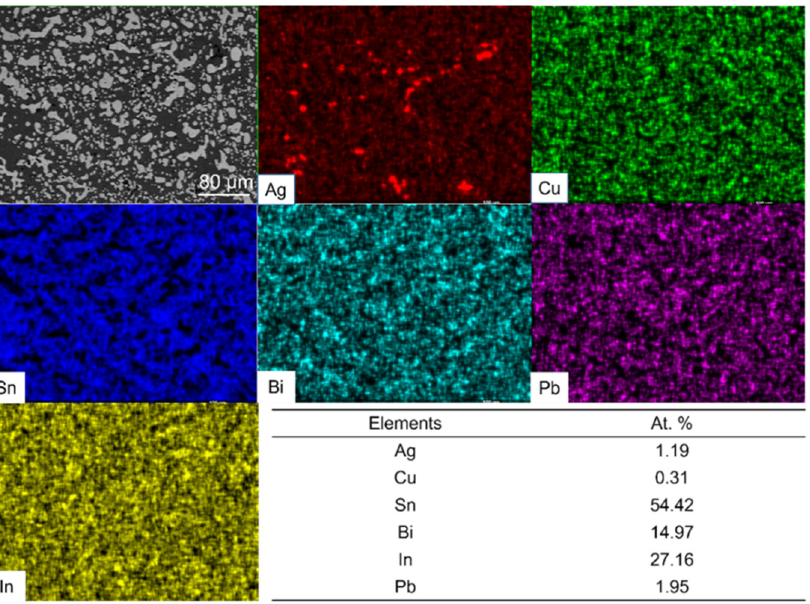
Figure 6. Elemental distribution and atomic percentage results of fully mixed composite solder joint.